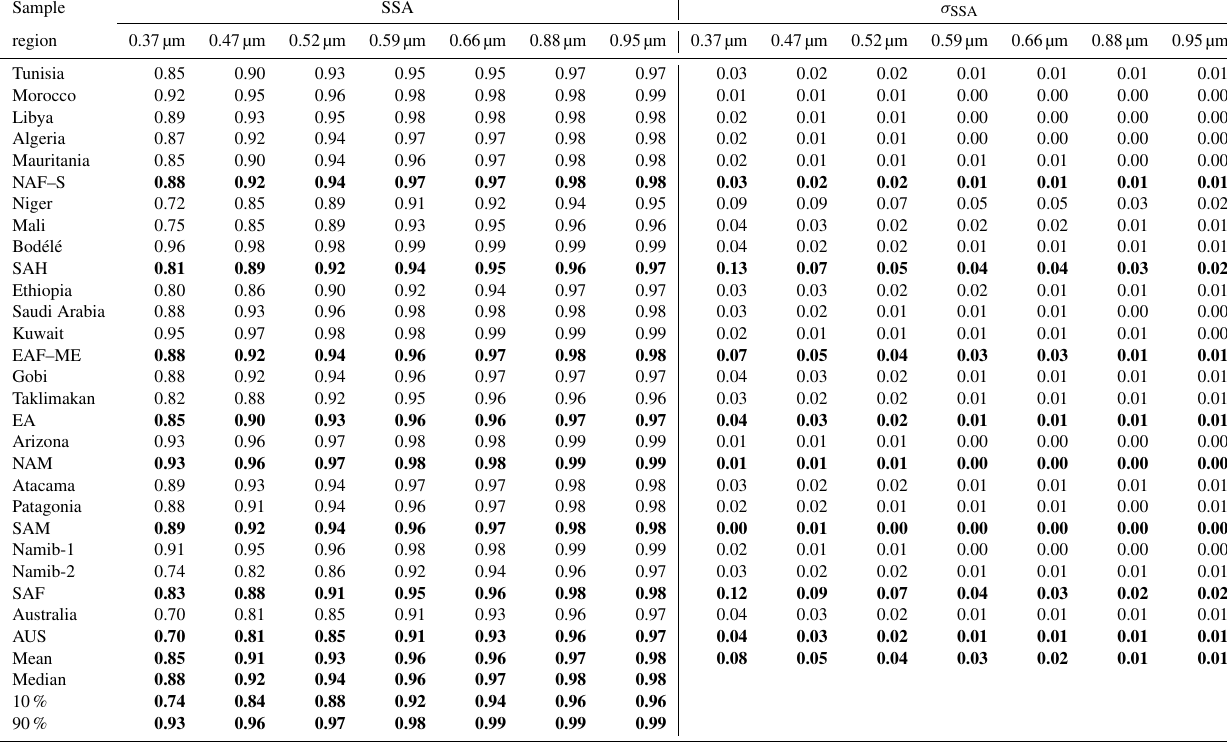
Table 5. As in Table 4 for the single-scattering albedo (SSA) data. Mean, median, and 10% and 90% values are indicated in bold font. Sample SSA